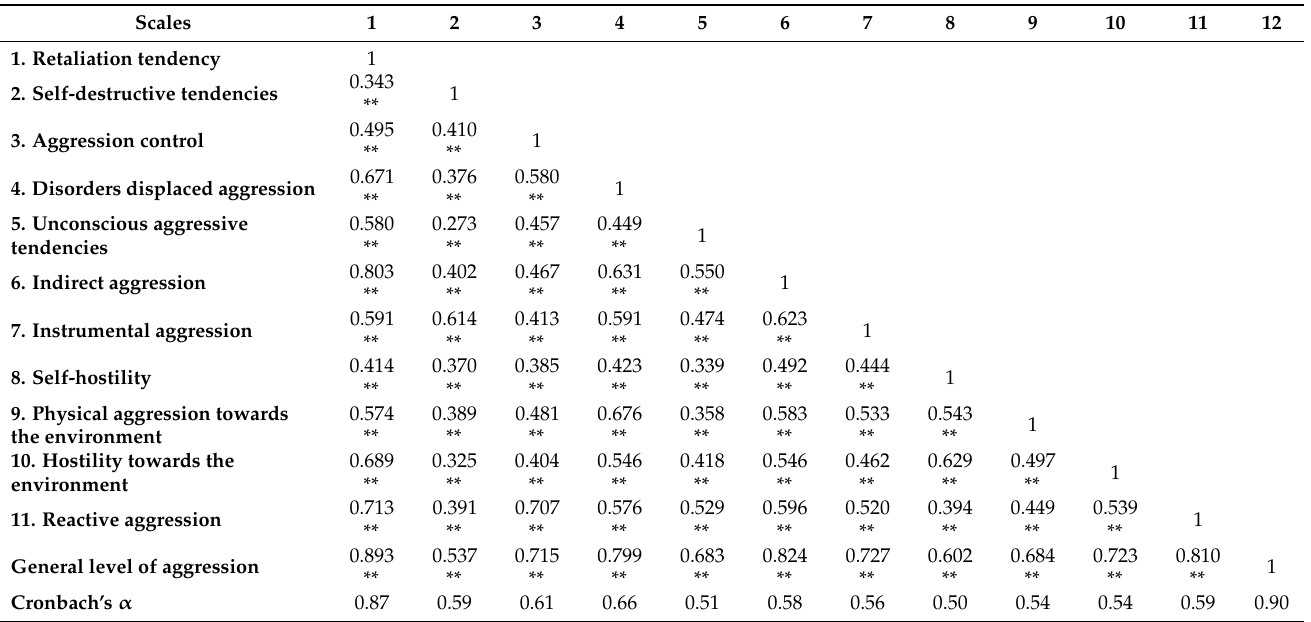
Table 5. Intercorrelations and Cronbach’s α for scales in the Aggression Syndrome Psychological Inventory (IPSA II) calculated for a group of seniors ( n =